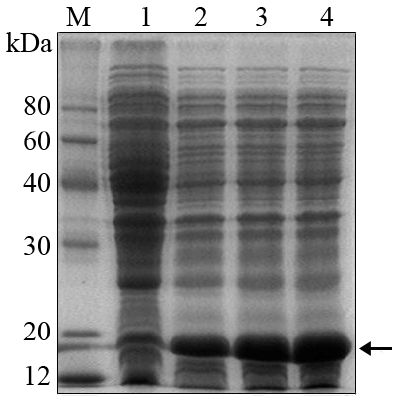
Figure 1. Duration of the expression of His- FIP-fve fusion protein. Lysates were obtained from E. coli (DE3) cells with pET30a- FIP-fve induced by 1 mM Isopropyl β -d-thiogalactoside (IPTG) and were analyzed on 12% SDS-PAGE. Lane M was a molecular weight marker. Lanes 1 to 4 were the samples induced for 0, 1.5, 3.0, and 4.5 h, respectively. The arrow indicated the target protein His- FIP-fve . 10 μ L sample was used in SDS-PAGE after